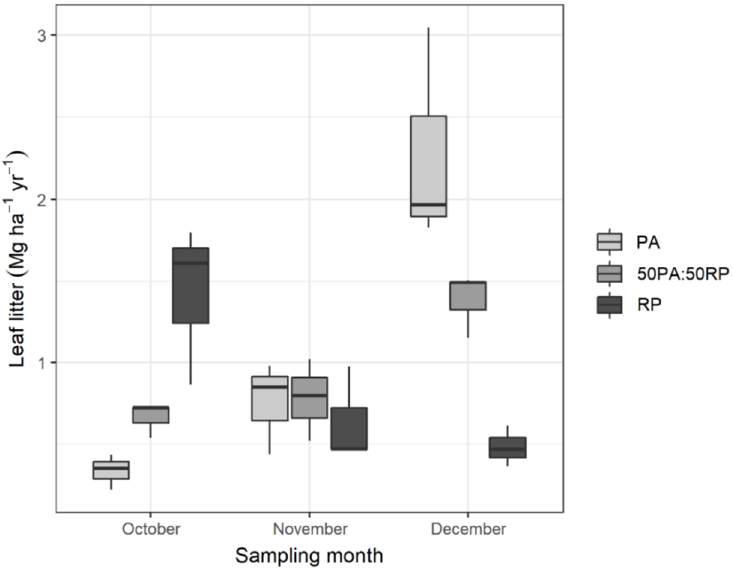
Figure 1. Monthly contribution (mg ha −1 yr −1 ) of the leaf litter in the P. alba (PA) and R. pseudoacacia (RP) monocultures, and the 50PA:50RP mixture.